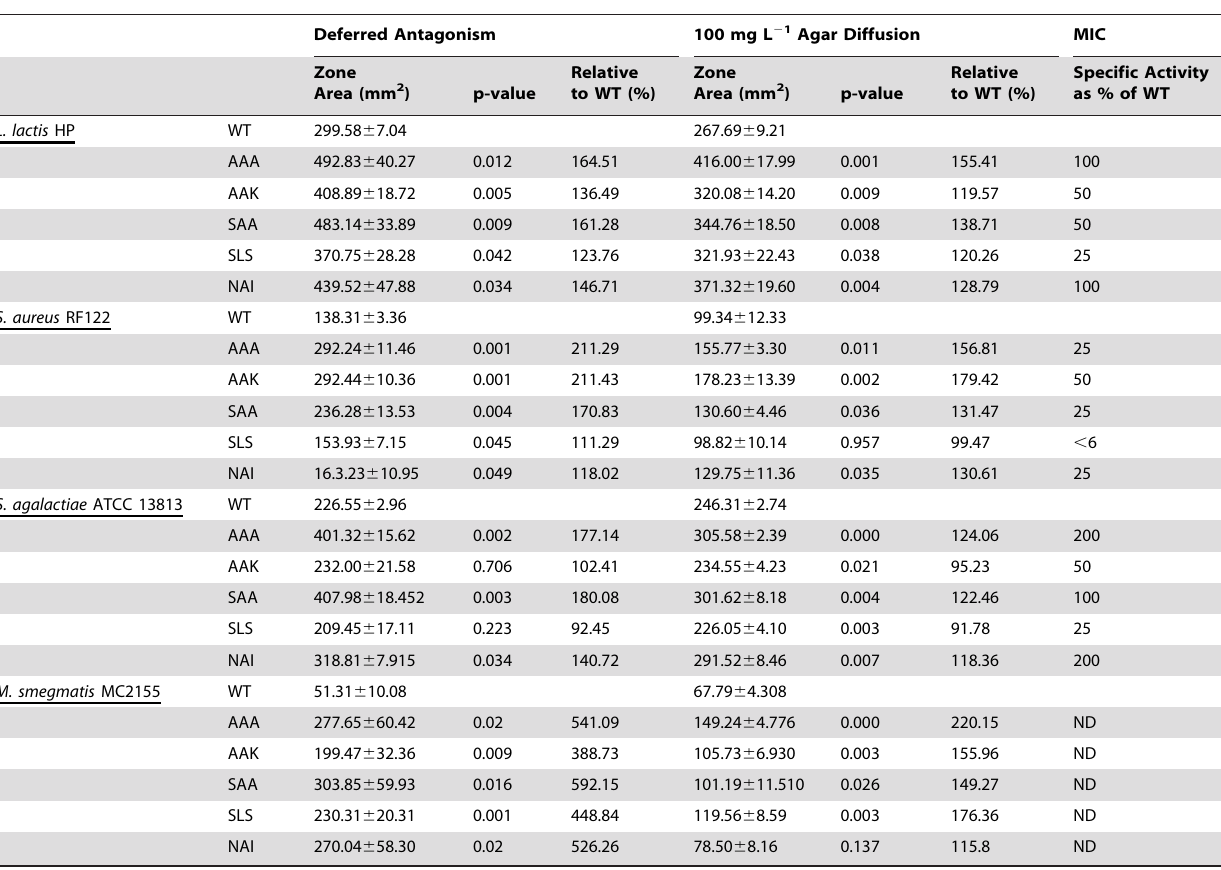
Table 6. Deferred Antagonism and Specific Activity